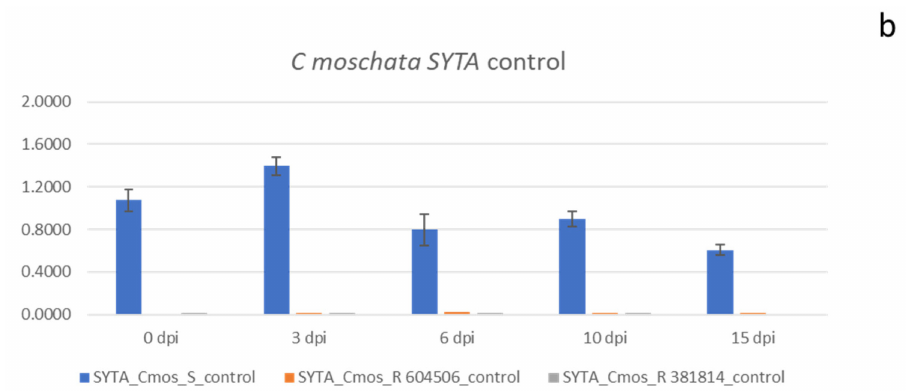
Figure 2. Expression profile of SYTA gene in C. moschata accessions. C. moschata plants ToLCNDV inoculated at 0, 3, 6, 10 and 15 dpi ( a ). Control plants of C. moschata accessions ( b ). Student’s t test associated probability in all cases, p ≤